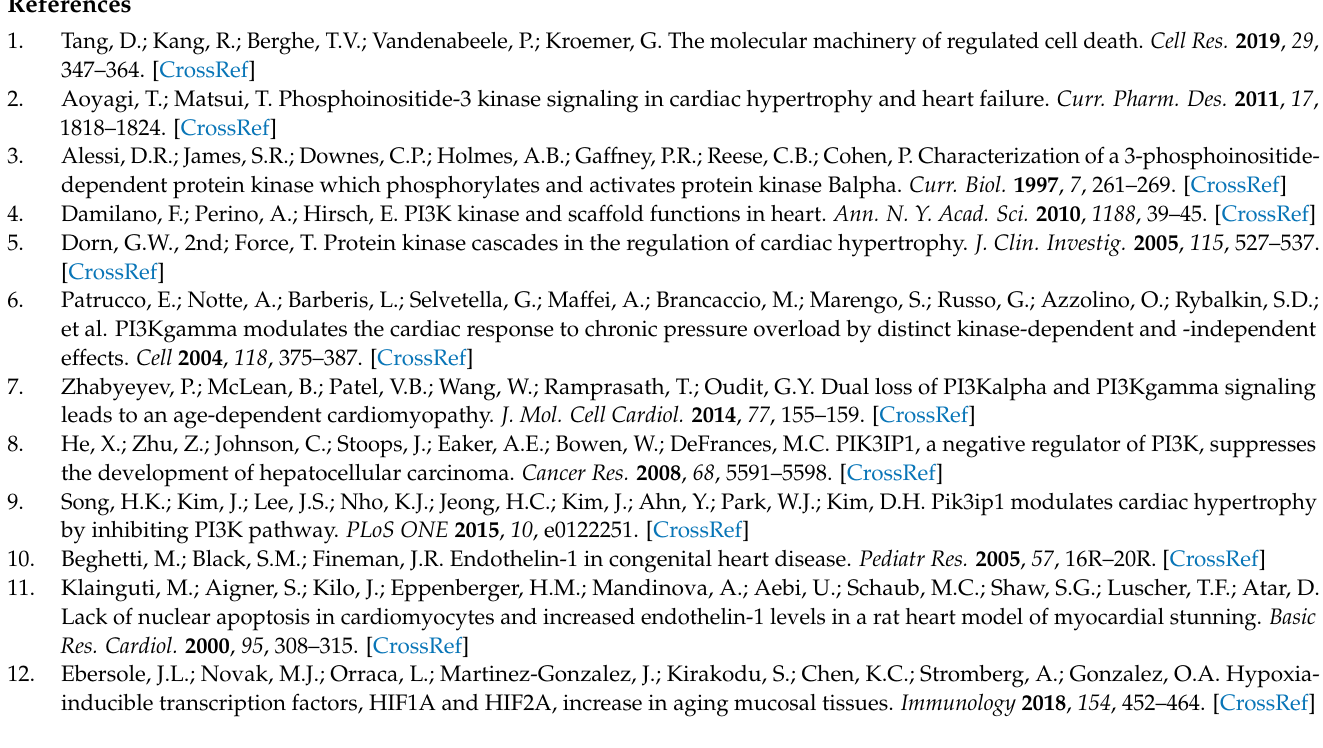
the present study; Supplementary Table S2: List of primer sets for the present study; Supplementary Figure S1: Echocardiography of PCKO mice underwent MI, and chemical time/dose conditions were tested; Supplementary Figure S2: Regulation of PIK3IP1 is related with eNOS-PKG-p-VASP signaling, antidoxidant enzyme expression and MAPK signaling; Supplementary Figures S3–S16: Uncropped gel